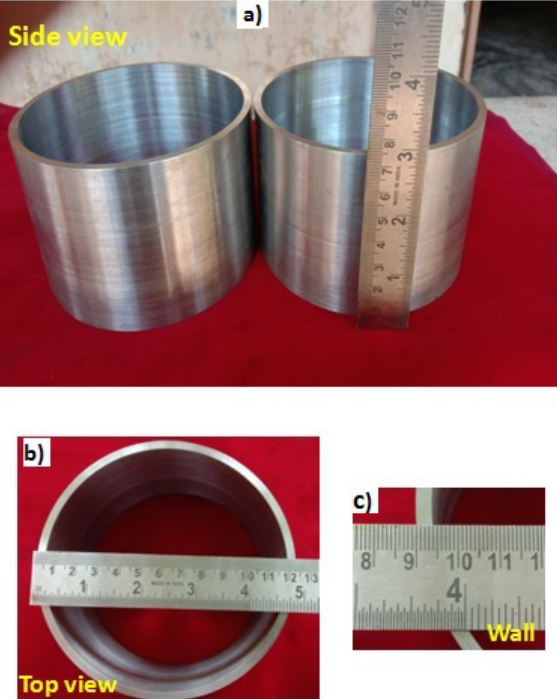
Figure 4: Photograph of low carbon steel cylindrical component (after machining), a) side view, b) top view and c) showing wall thickness.